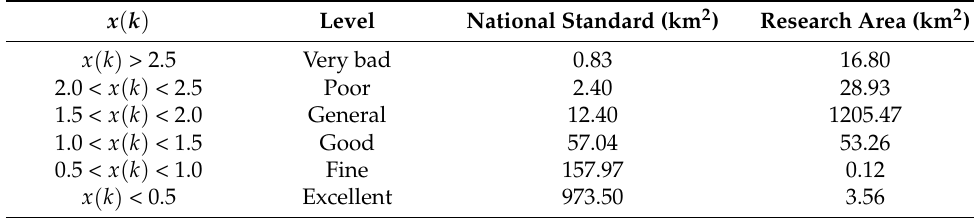
Table 7. Comprehensive evaluation results of